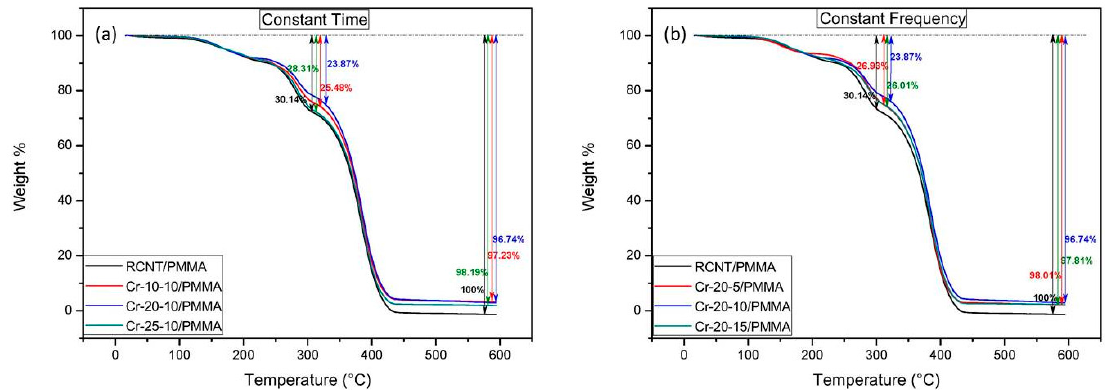
Figure 7. Thermograms of the different CNT/poly(methyl methacrylate) (PMMA) composites: ( a ) RCNT, Cr-10-10, Cr-20-10, and Cr-25-10; and ( b ) RCNT, Cr-20-5, Cr-20-10, and Cr-20-15. Among all, the sample Cr-20-10 is the most stable.